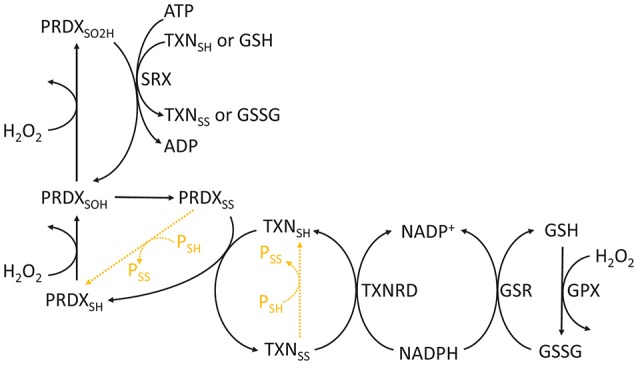
Chemical cycle of PRDXs, TXNs, and GSH. The redox state of PRDXs and TXN is indicated as follows: SH, reduced cysteine thiol; SOH, sulfenic acid; SO2H, sulfinic acid; SS, disulfide. Orange dashed reactions highlight disulfide exchange between peroxiredoxins and thioredoxins and other proteins.